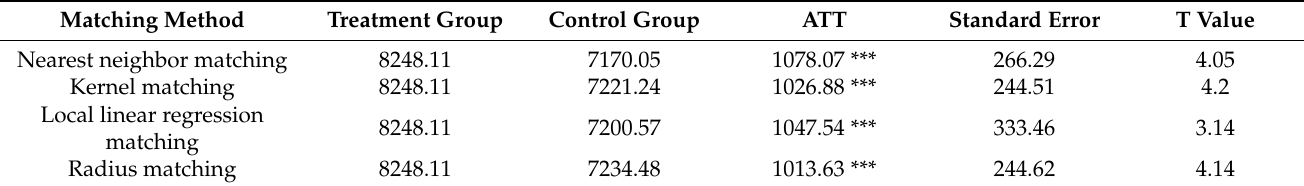
Table 4. PSM results of the impact of Internet use on grain production.